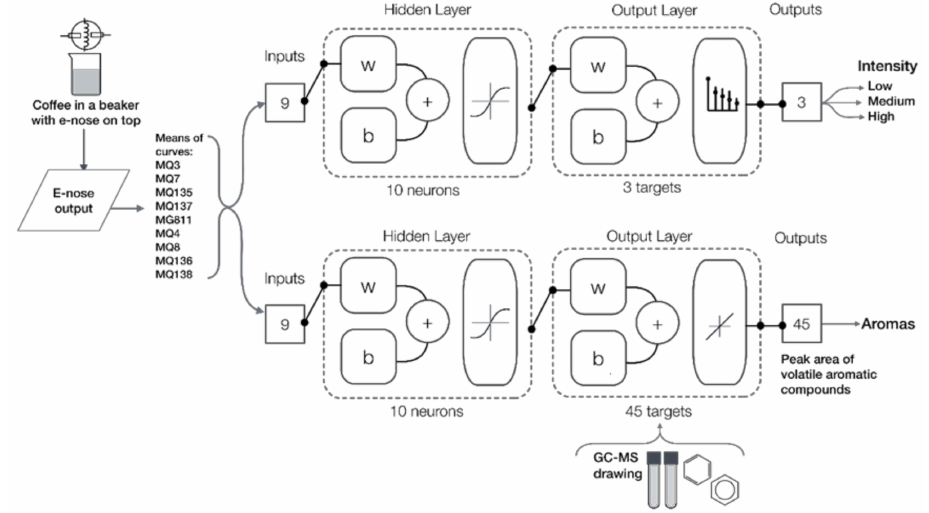
Figure 2. Diagram of the pattern recognition Model 1 (top) to classify samples into low-, medium-, and high-intensity, and regression Model 2 (bottom) to predict the peak area of 45 volatile aromatic compounds using the outputs from the electronic nose as inputs for both models. Abbreviations: b: bias; W: weights; sensors descriptions are presented in Table 2. Targets/outputs from Model 2 can be found in Table 3 (Results and